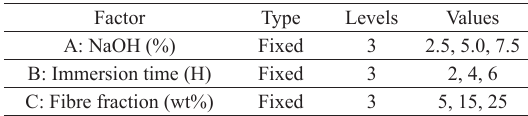
Table 1. Factors and levels of the Taguchi